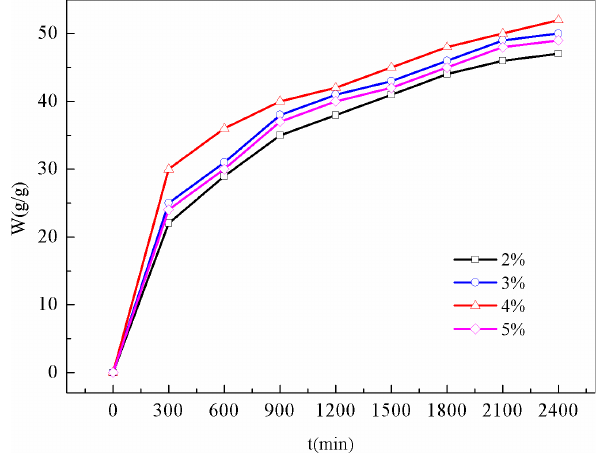
Figure 3: The brine absorption of foam gel at different SDS concen-